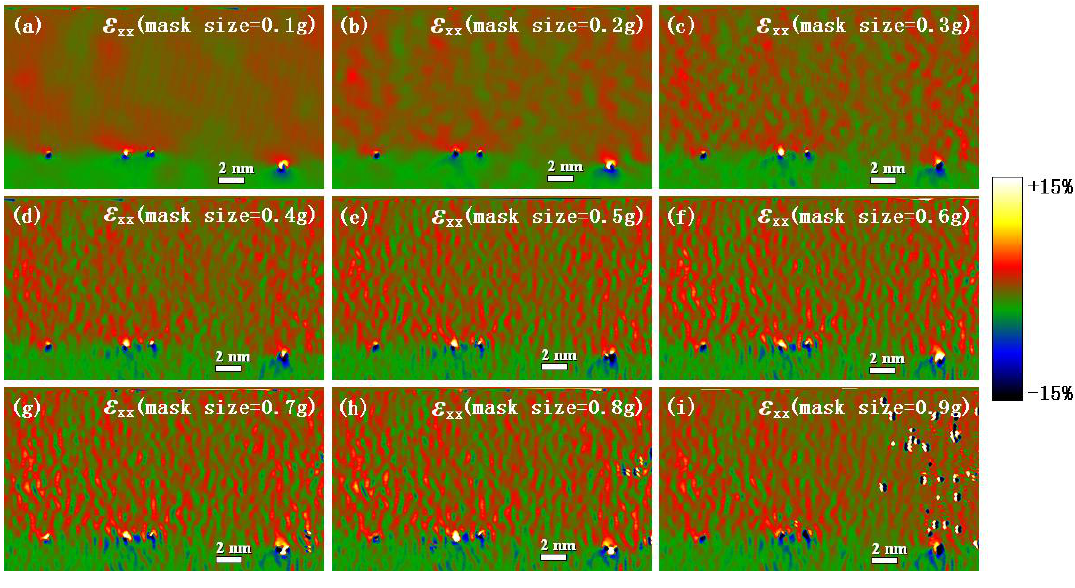
Figure 4. Experimental strain components ε corresponding to different mask sizes determined by peak pairs analysis